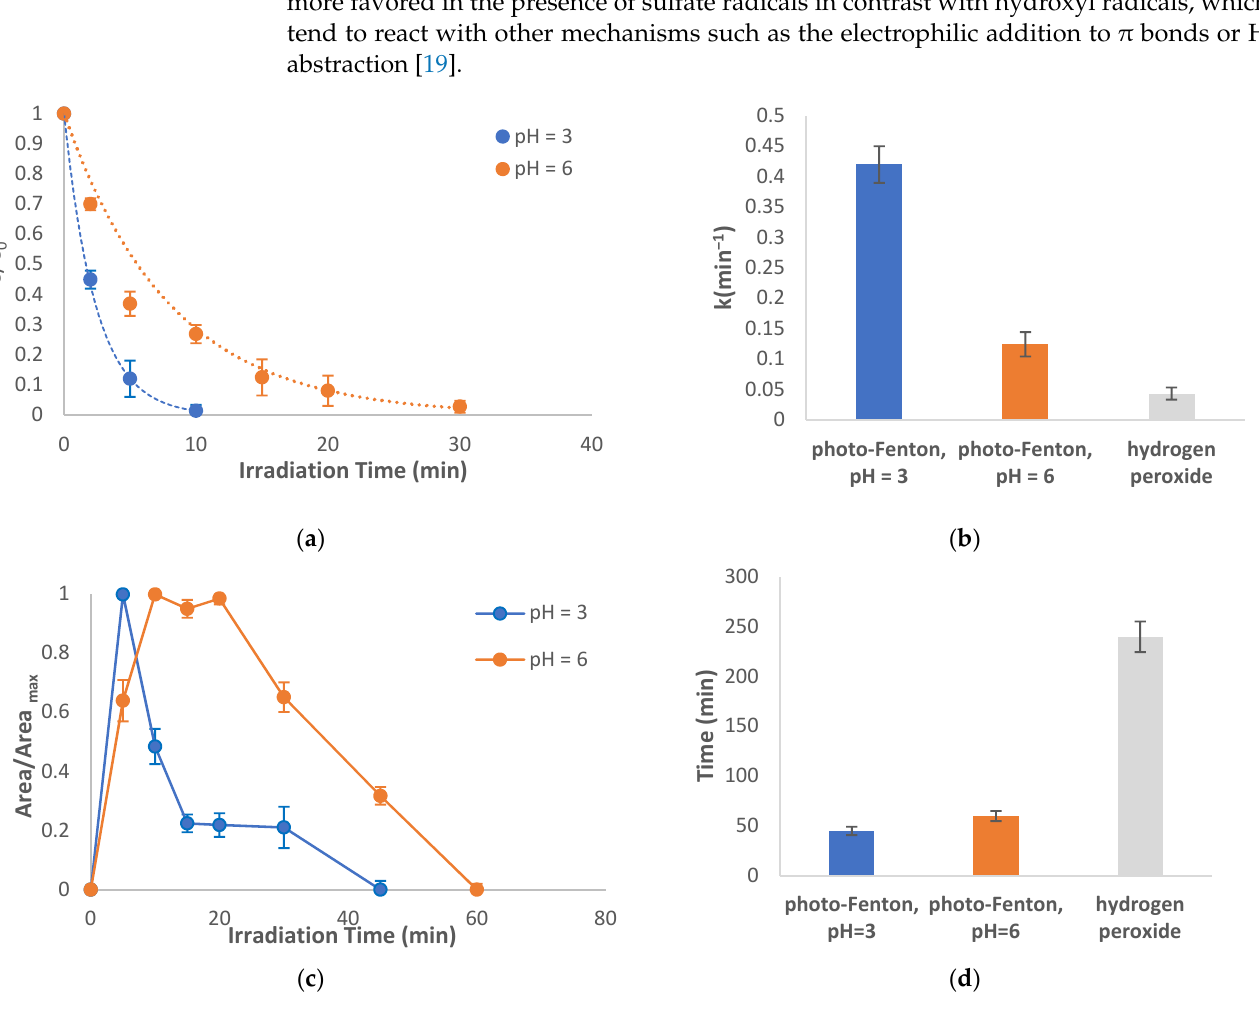
Figure 4. Photocatalytic treatment using the photo-Fenton reaction: ( a ) degradation of the parent compound at pH = 3 and 6, ( b ) rate constants of the degradation of abacavir, ( c ) evolution profiles of TP-247, and ( d ) time required for complete disappearance of TP-247. C 0 = 10 mg/L, CFe 2+ =1 mg/L, C oxidant = 15 mg/L, matrix = ultrapure water.